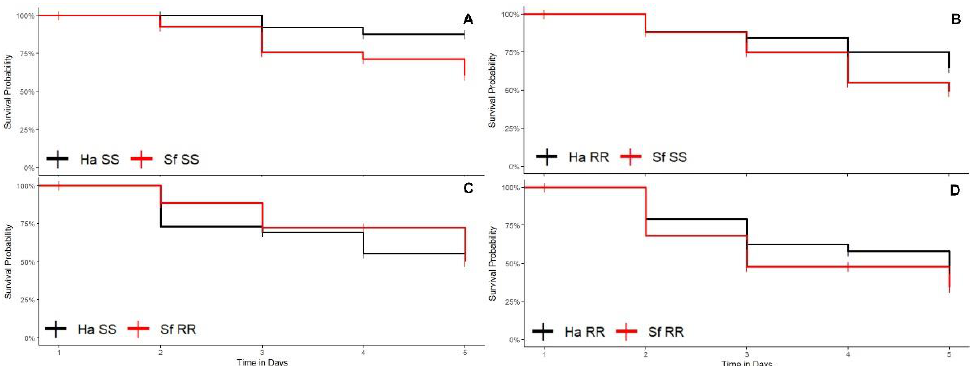
Figure 5. Larval survival curves of strains susceptible (SS) and resistant (RR) to insecticides of Helicoverpa armigera (Ha) and Spodoptera frugiperda (Sf) maintained in competition in soybean plants. ( A ) Ha-SS versus Sf-SS interaction; ( B ) Ha-RR versus Sf-SS interaction; ( C ) Ha-SS interaction with Sf-RR and ( D ) Ha-RR interaction with Sf-RR.